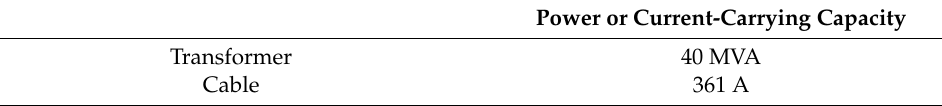
Table 3. Standard equipment adopted for the planning of MV grids [1].